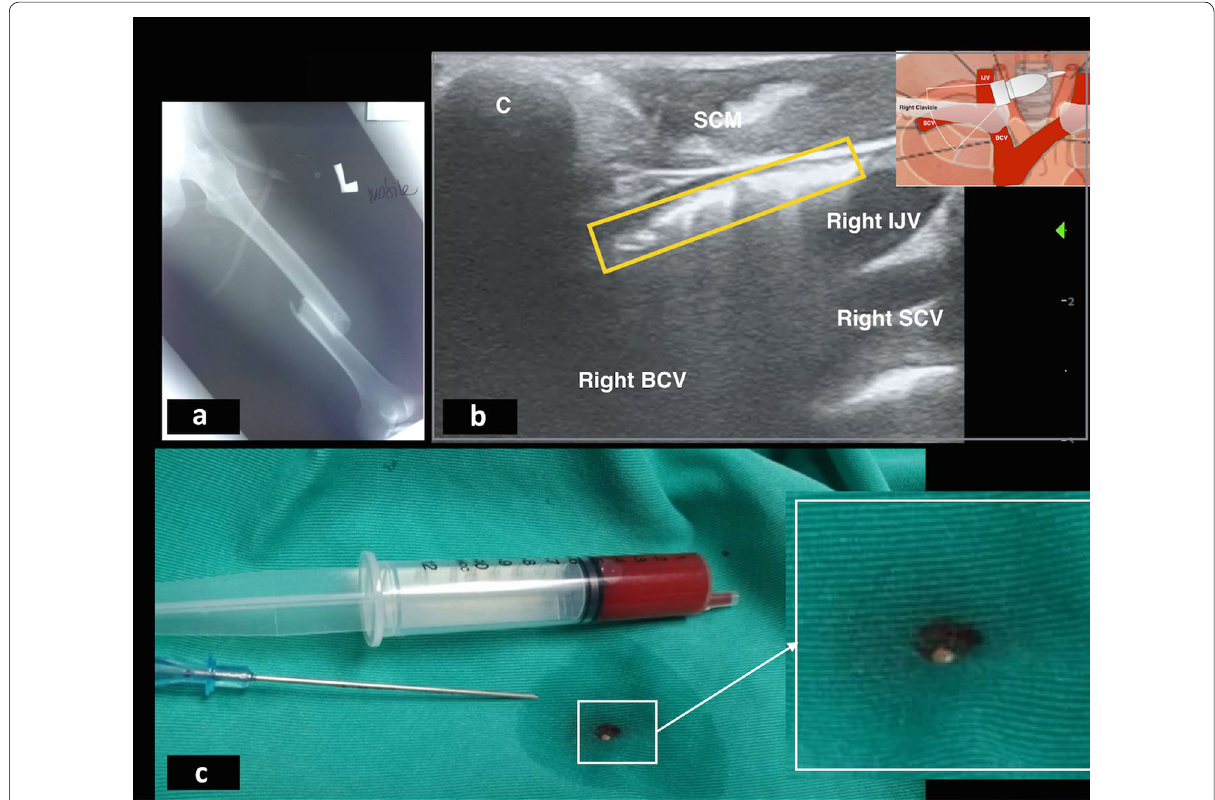
Fig. 1 a X-ray showed closed fracture right femoral shaft. b Ultrasound images revealed free floating mobile hyperechoic spots, located in the anterior part of the vein and cleared from the vein (yellow box). Small picture showing probe location in relation to clavicle, internal jugular vein, subclavian vein and brachiocephalic vein. c Fat globule was aspirated during cannulation of the IJV as shown in the white box. C Clavicle, IJV internal jugular vein, SCV subclavian vein, BCV brachiocephalic